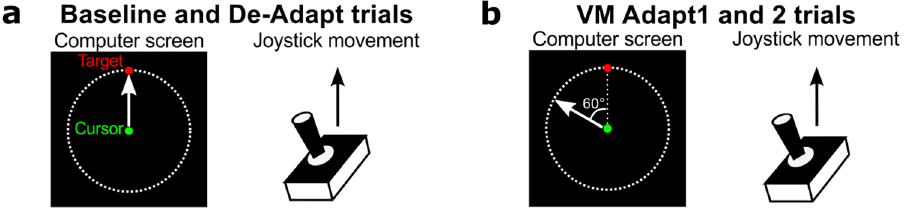
Figure 1. Relationship between the joystick movements and cursor movements for the different types of trials. ( a ) In the baseline and de-adaptation trials, the movement of the green cursor followed the exact path of the joystick movement. ( b ) For the visuomotor adaptation trials (VM Adapt1 and 2), the movement of the green cursor was rotated by 60 degrees anti-clockwise relative to the joystick movement. Note that the red target was presented randomly to one of 8 equidistant positions located on the dashed line